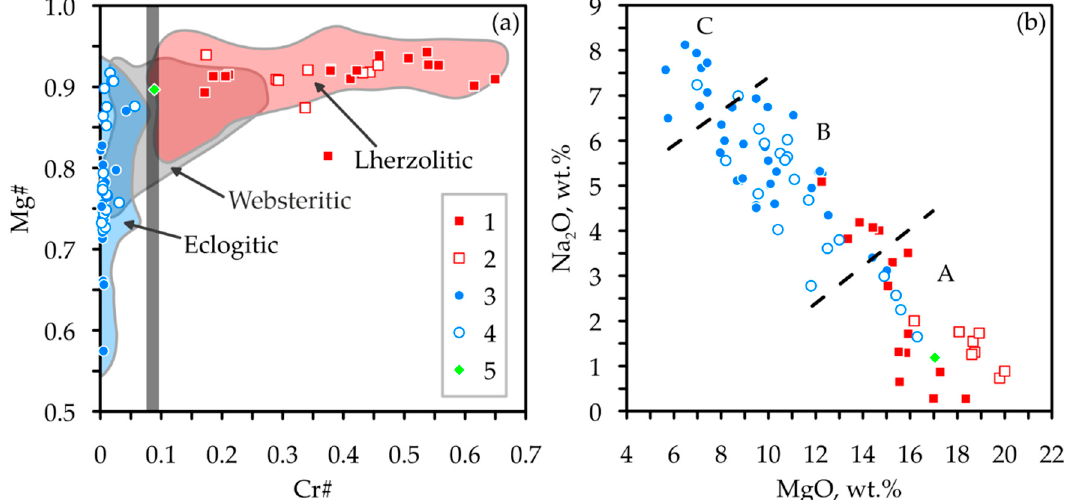
Figure 1. The discrimination of clinopyroxenes of different paragenesis: ( a ) Mg# vs. Cr# of clinopyroxenes—lherzolitic, websteritic, and eclogitic compositional fields and the transition from peridotite to eclogite clinopyroxenes at Cr# 0.07–0.10 (gray vertical stripe) are taken from [2]; ( b ) Na 2 O